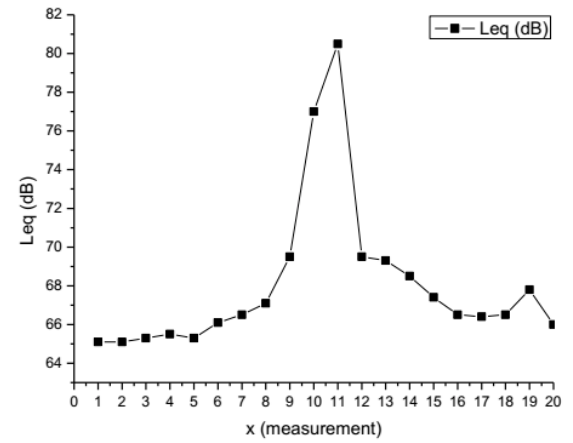
Figure 17. Empirical Noise level (OS-T) of 66° oriented building toward runway.